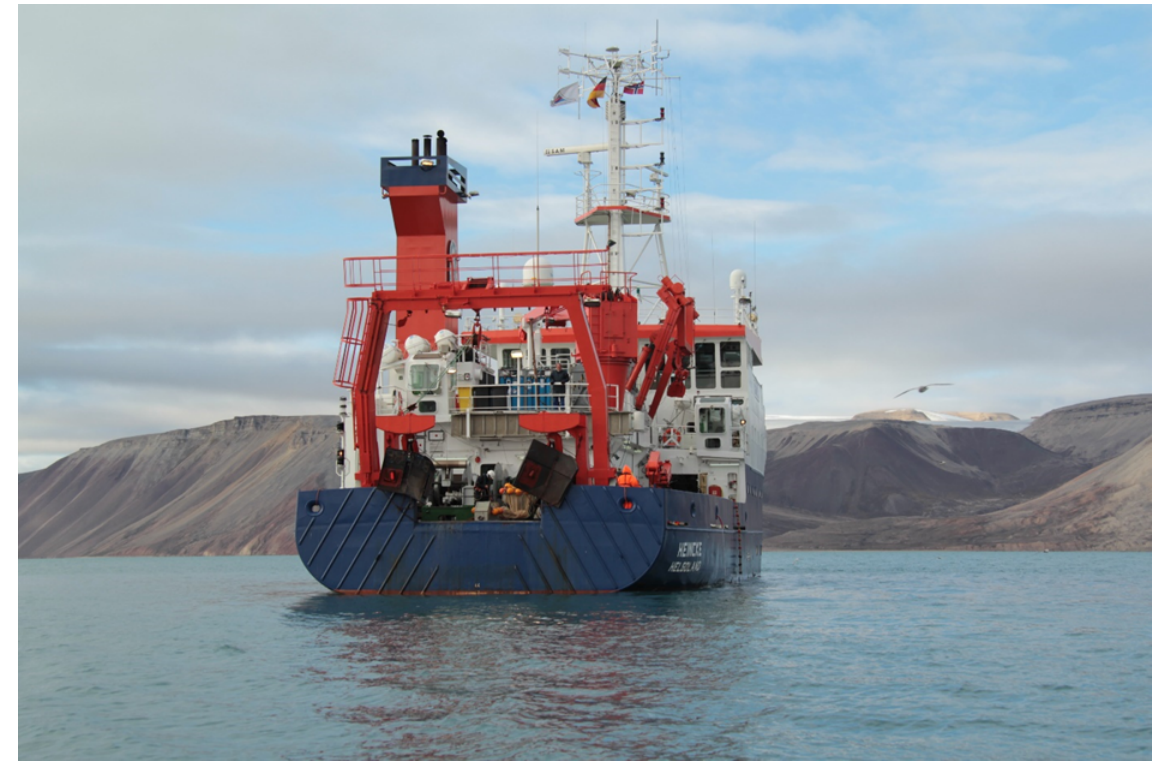
Figure 3: Heincke in coastal waters of Svalbard (Arctic). Photo: AWI / K.